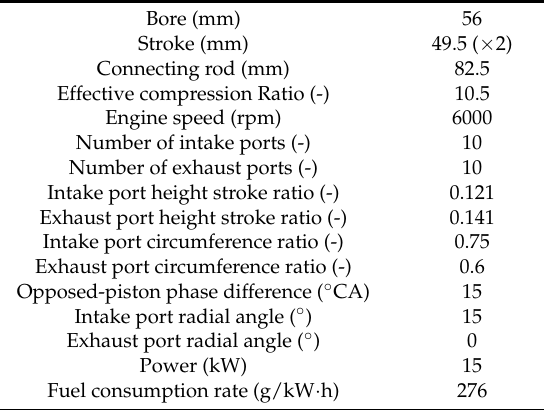
Figure 1. Configuration of OP2S-GDI engine. ( a ) Section of OP2S-GDI engine; ( b ) Opposed crank-connecting rod mechanism. Table 1. OP2S-GDI engine